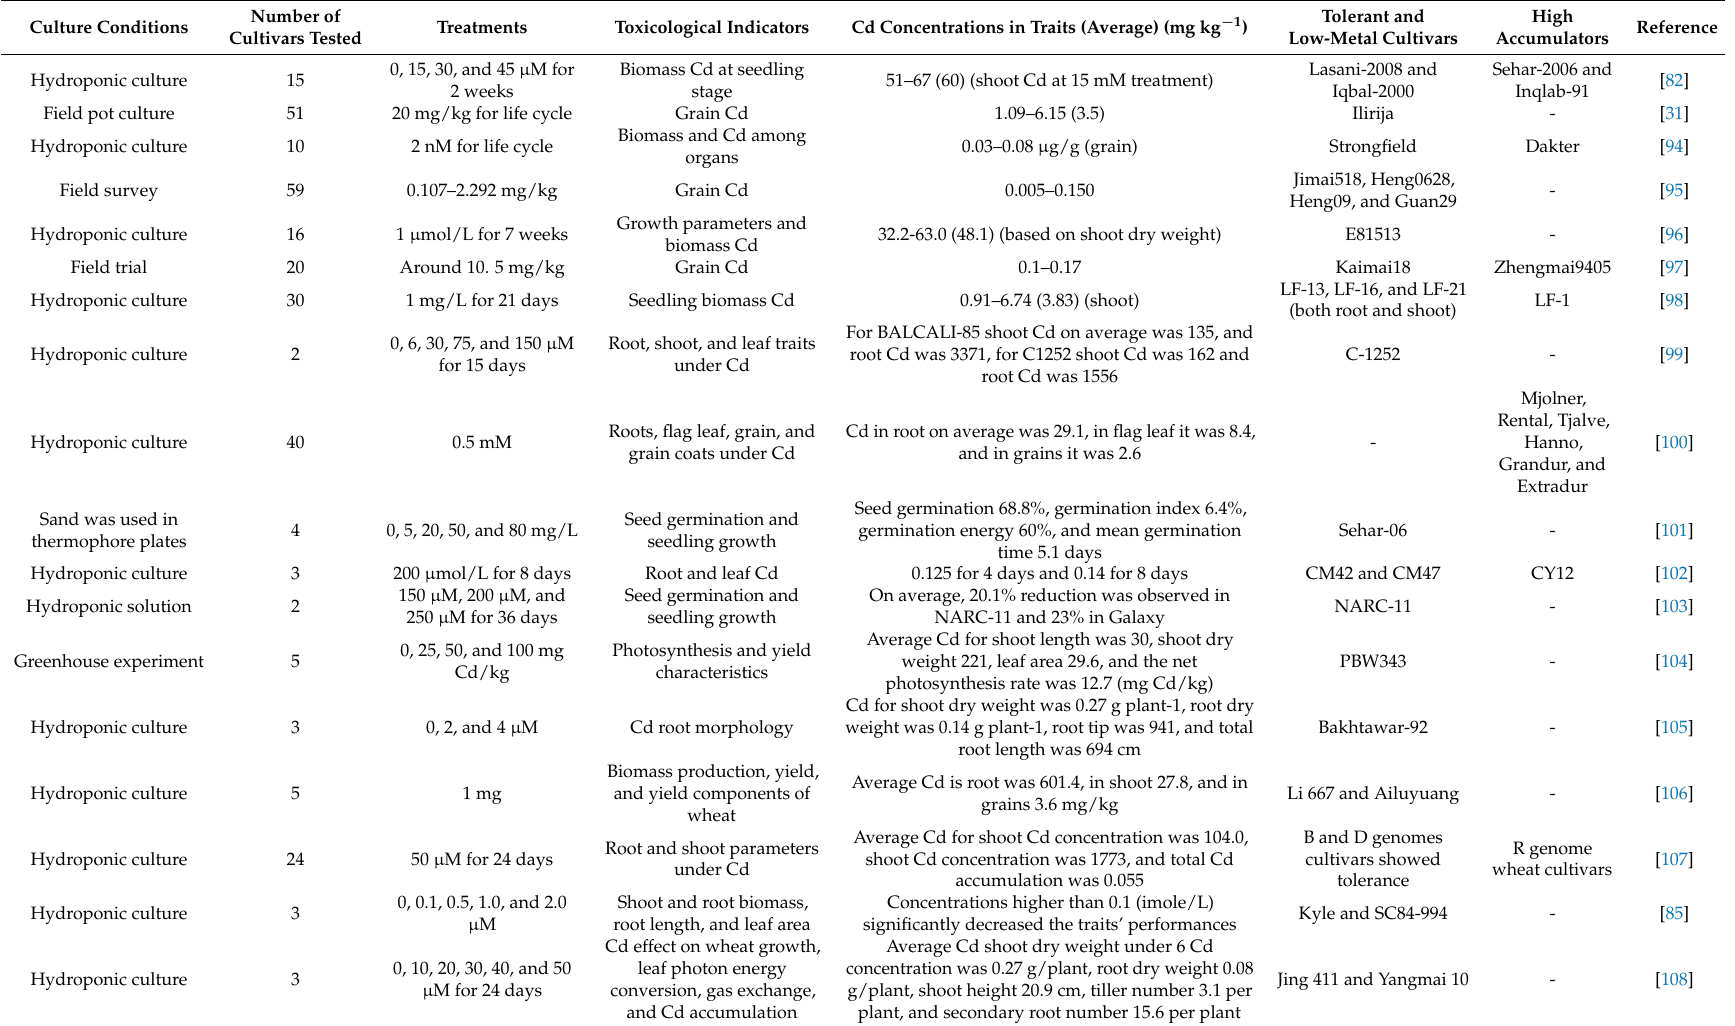
Table 1. Phenotypic evaluation of wheat cultivars under Cd